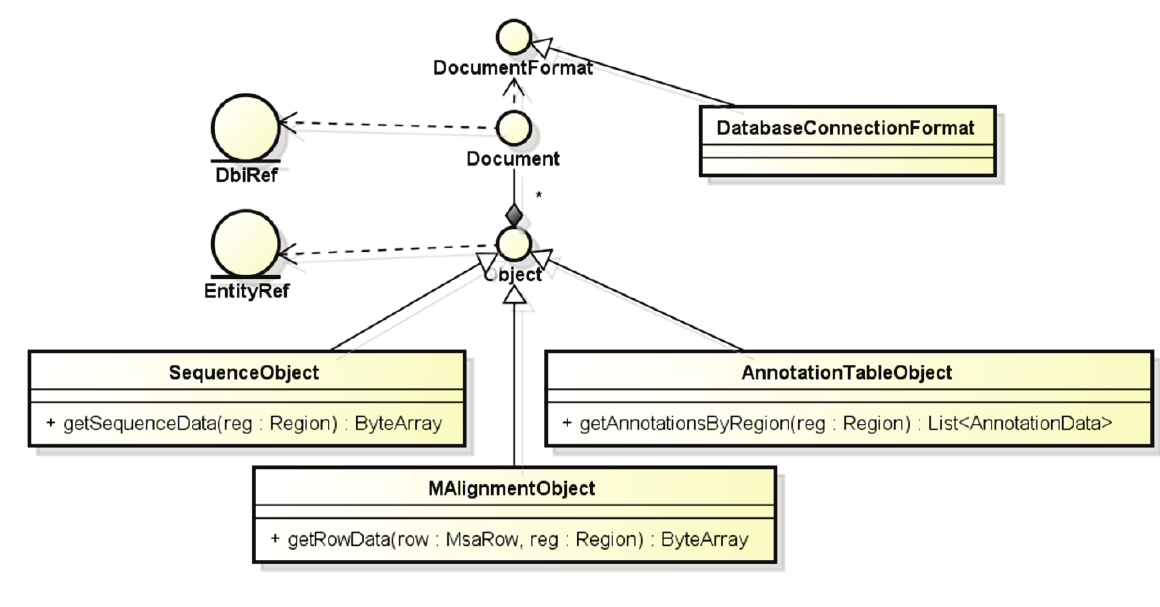
Figure 1: UGENE data sources diagram. The key entity here is “Document” containing a set of “Object” instances that can belong to different data types. Sequences, multiple sequence alignments and annotations are given as an example. The document has a reference to a database, where its objects are stored. At the same time, each object has a reference to particular records in the database. “Document format” is an entity that determines a document initialization procedure and encapsulates low-level input/output operations. Different document formats exist for various file formats and